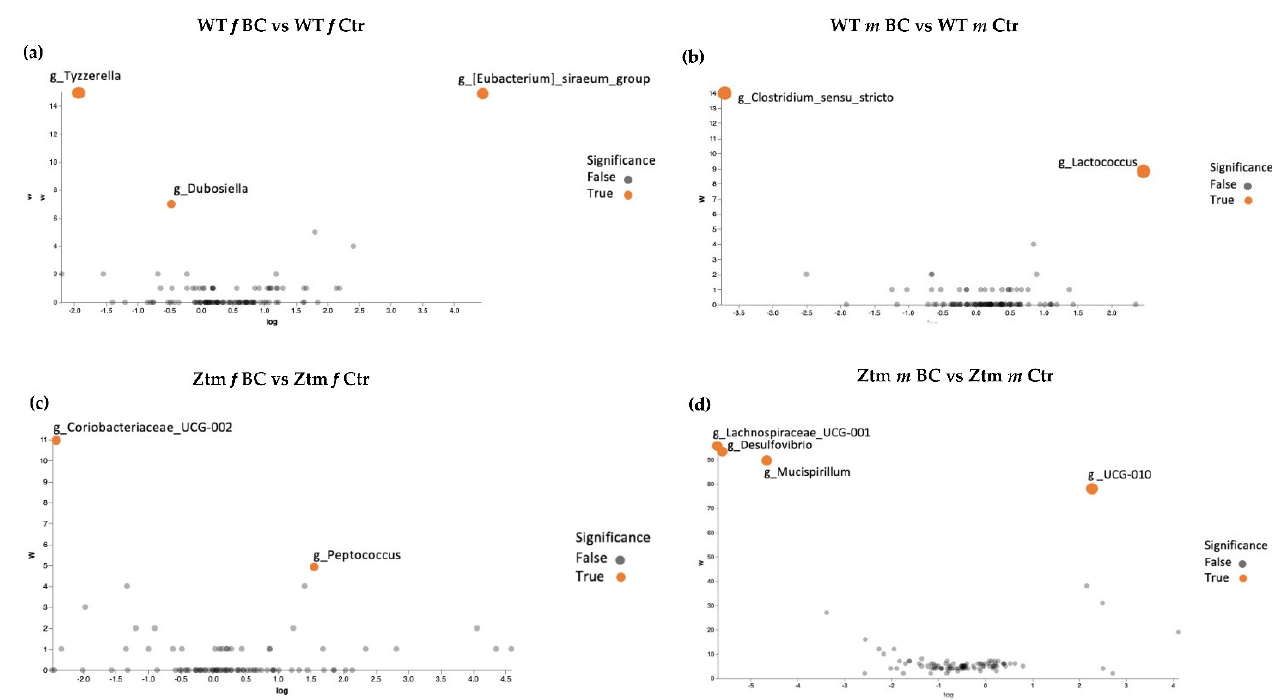
Figure 7. ANCOM volcano plot of statistical differences between treatment groups (WT BC & Ztm BC) and control groups (WT Ctr & Ztm Ctr) at genus level. ( a ): WT f BC harbor a significant increased abundance of Eubacterium (Ruminococcaceae family) and a significantly reduced abundance of Tyzzerella (Lachnospiraceae family) and Dubosiella (Erysipelotrichaceae family) compared with control group. ( b ): WT m BC harbor a significantly increased abundance of Lactococcus (Streptococcaceae family) and a significantly reduced abundance of Clostridium sensu stricto 1 (Clostridiaceae family) compared with control group. ( c ): Ztm f BC harbor a significantly reduced abundance of Coriobacteriaceae UCG-002 (Atopobiaceae family) and Peptococcus (Peptococcaceae family) compared with control group. ( d ): Ztm m BC harbor a significantly reduced abundance of Lachnospiraceae UCG-001 (order Clostridia), Desulfovibrio (Desulfovibrionacea family), and Mucispirillum (Deferribacteraceae family) and a significant increased abundance of UCG-010 (order Oscillospirales) compared with control group. WT = wild-type mice; Ztm = zonulin transgenic mice; Ctr = control mice; BC = bovine colostrum treatment; f = female; m = male. The WT female BC group harbored an increased abundance of the R uminococcus and